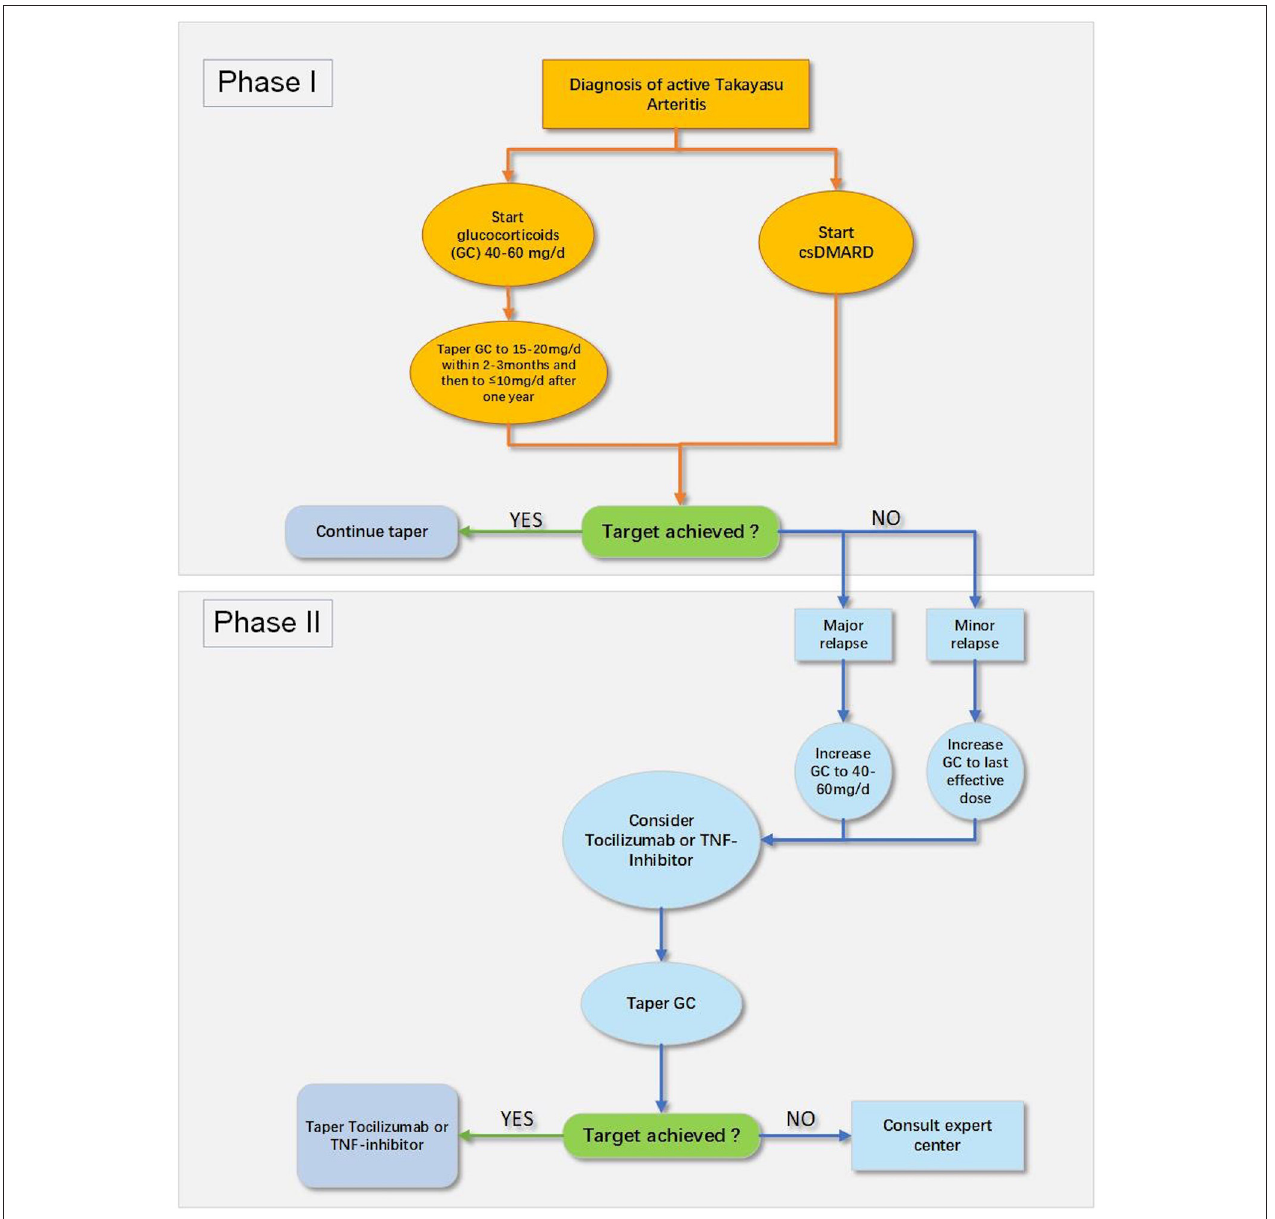
FIGURE 2 | The 2018 EULAR recommendation for pharmacological treatment of Takayasu arteritis (TA) (24). csDMARD, conventional synthetic disease-modifying antirheumatic drug; GC, glucocorticoids; TNF, tumor necrosis